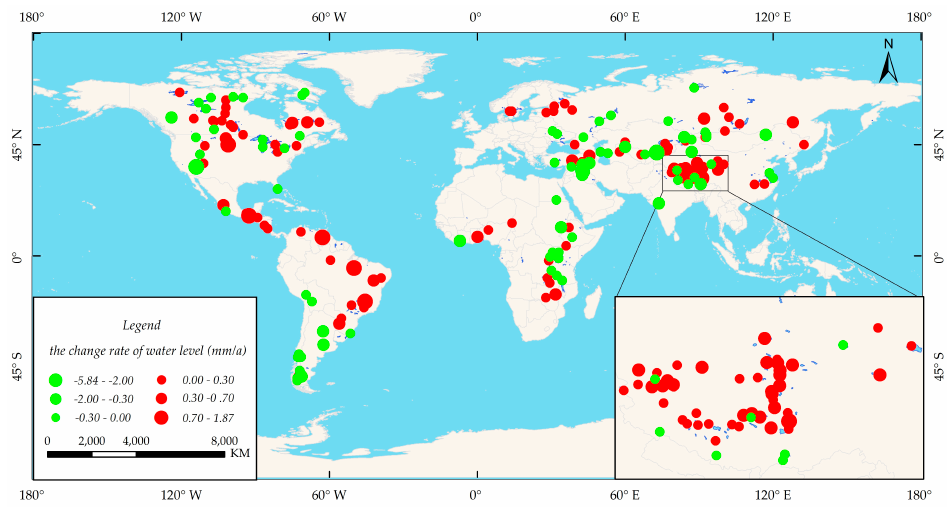
Figure 1. Classification of the change rates of lake levels.